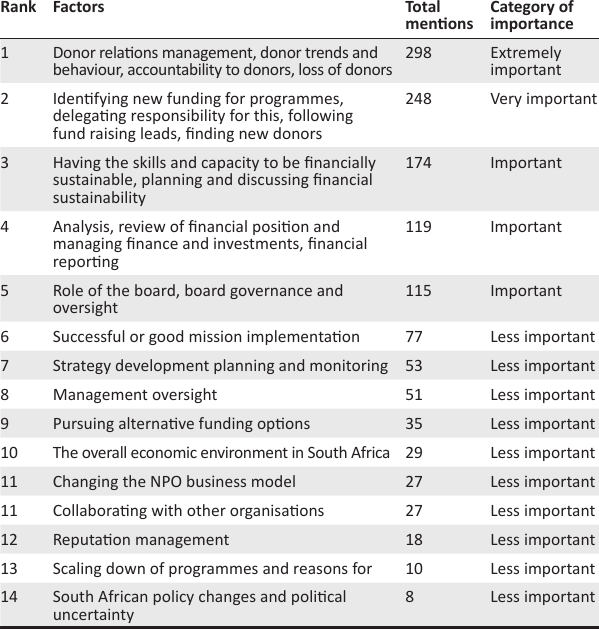
TABLE 2: Key themes and their order of